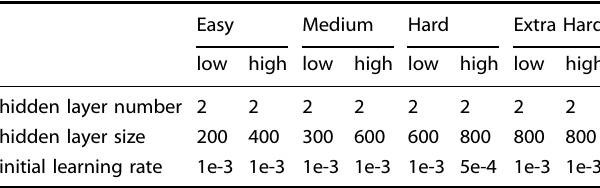
Table 6. Neural network parameters for all